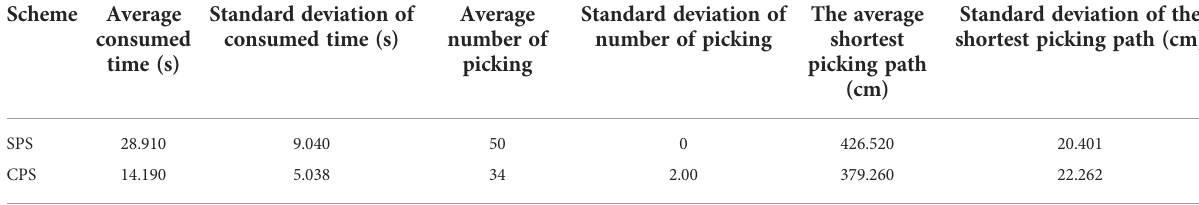
SPS, single-point picking scheme; CPS, combined multipoint picking